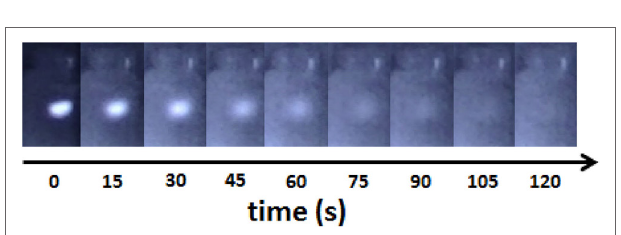
FigUre 7 | Heat trace decay over time for PET. After 2 min the heat trace was difficult to see.